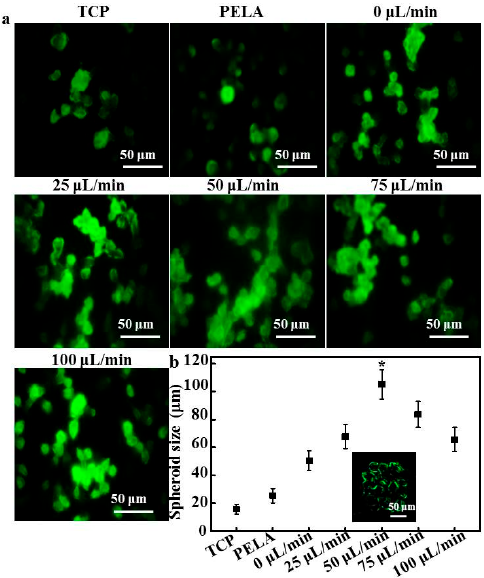
Figure 3. ( a ) Confocal laser scanning microscopy (CLSM) images of immunofluorescent staining of albumin by hepatocytes after 15 days; ( b ) The size distribution of hepatocyte spheroids after 15 days ( n = 5, * p < 0.05); Inset shows a CLSM image of the biliary excretory function of hepatocyte spheroids under a flow rate of 50 μ L/min.